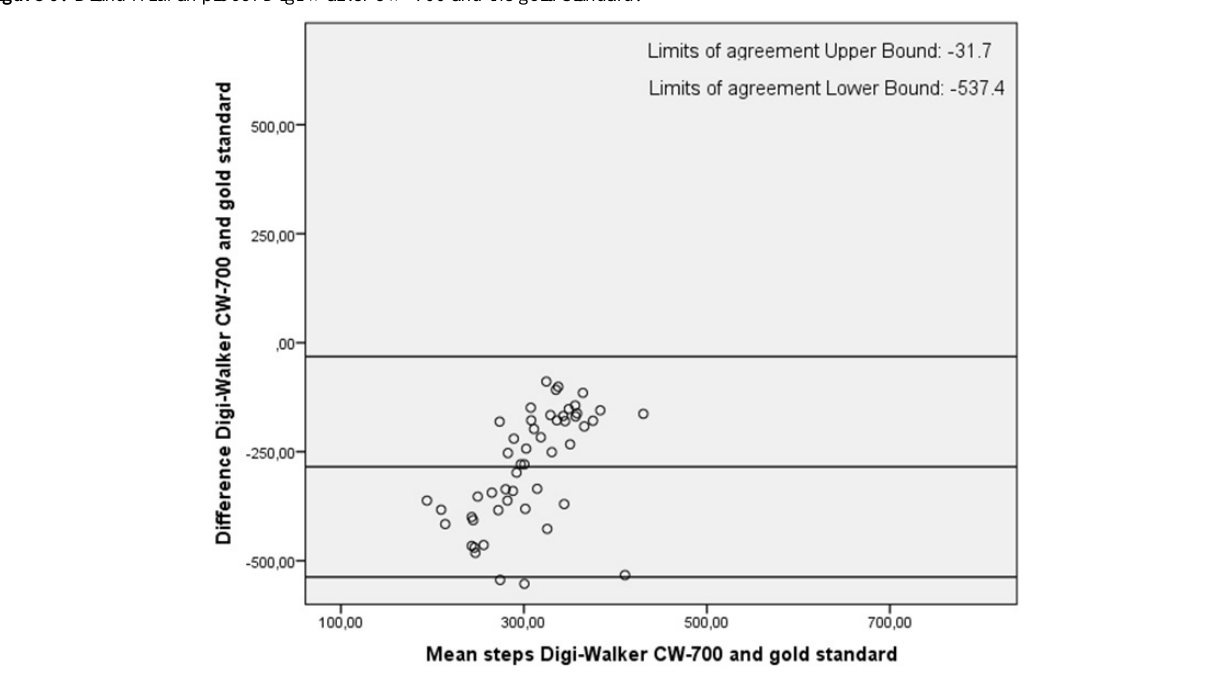
Figure 6. Bland-Altman plot of Digi-Walker CW-700 and the gold